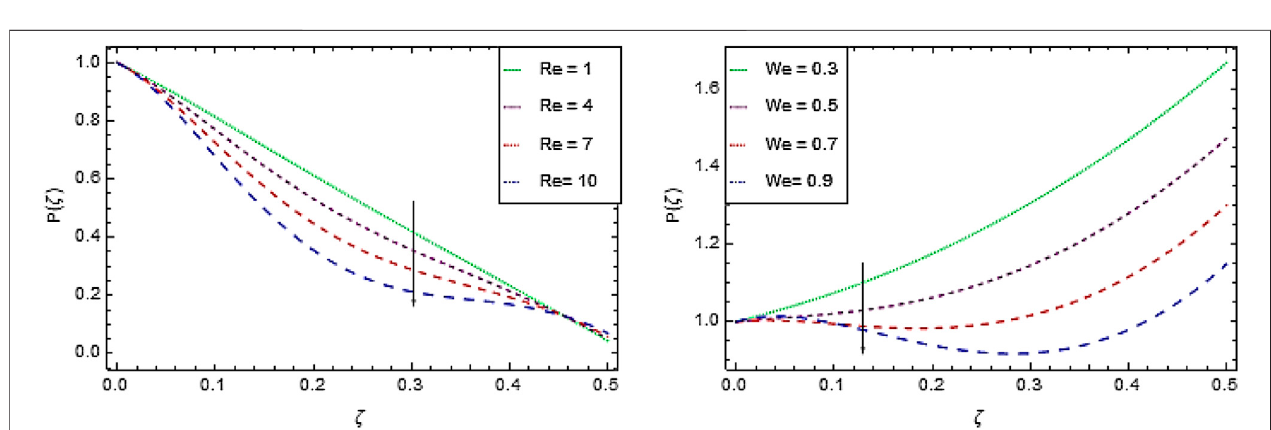
FIGURE 4 | P ( ς ) as a function of (A) Re (B) We